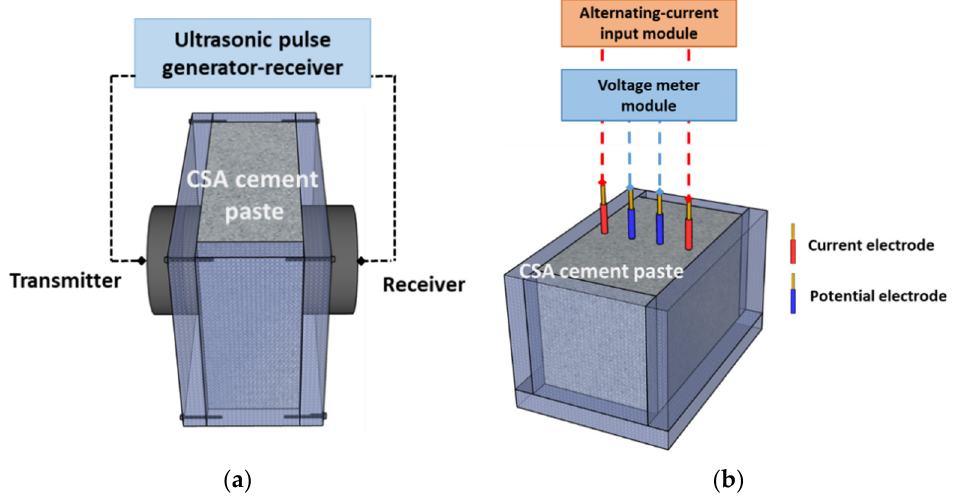
Figure 4. Experimental setup for nondestructive evaluation method 24 h after mixing of CSA pastes: ( a ) ultrasonic velocity measurement system, and ( b ) electrical resistivity measurement system.